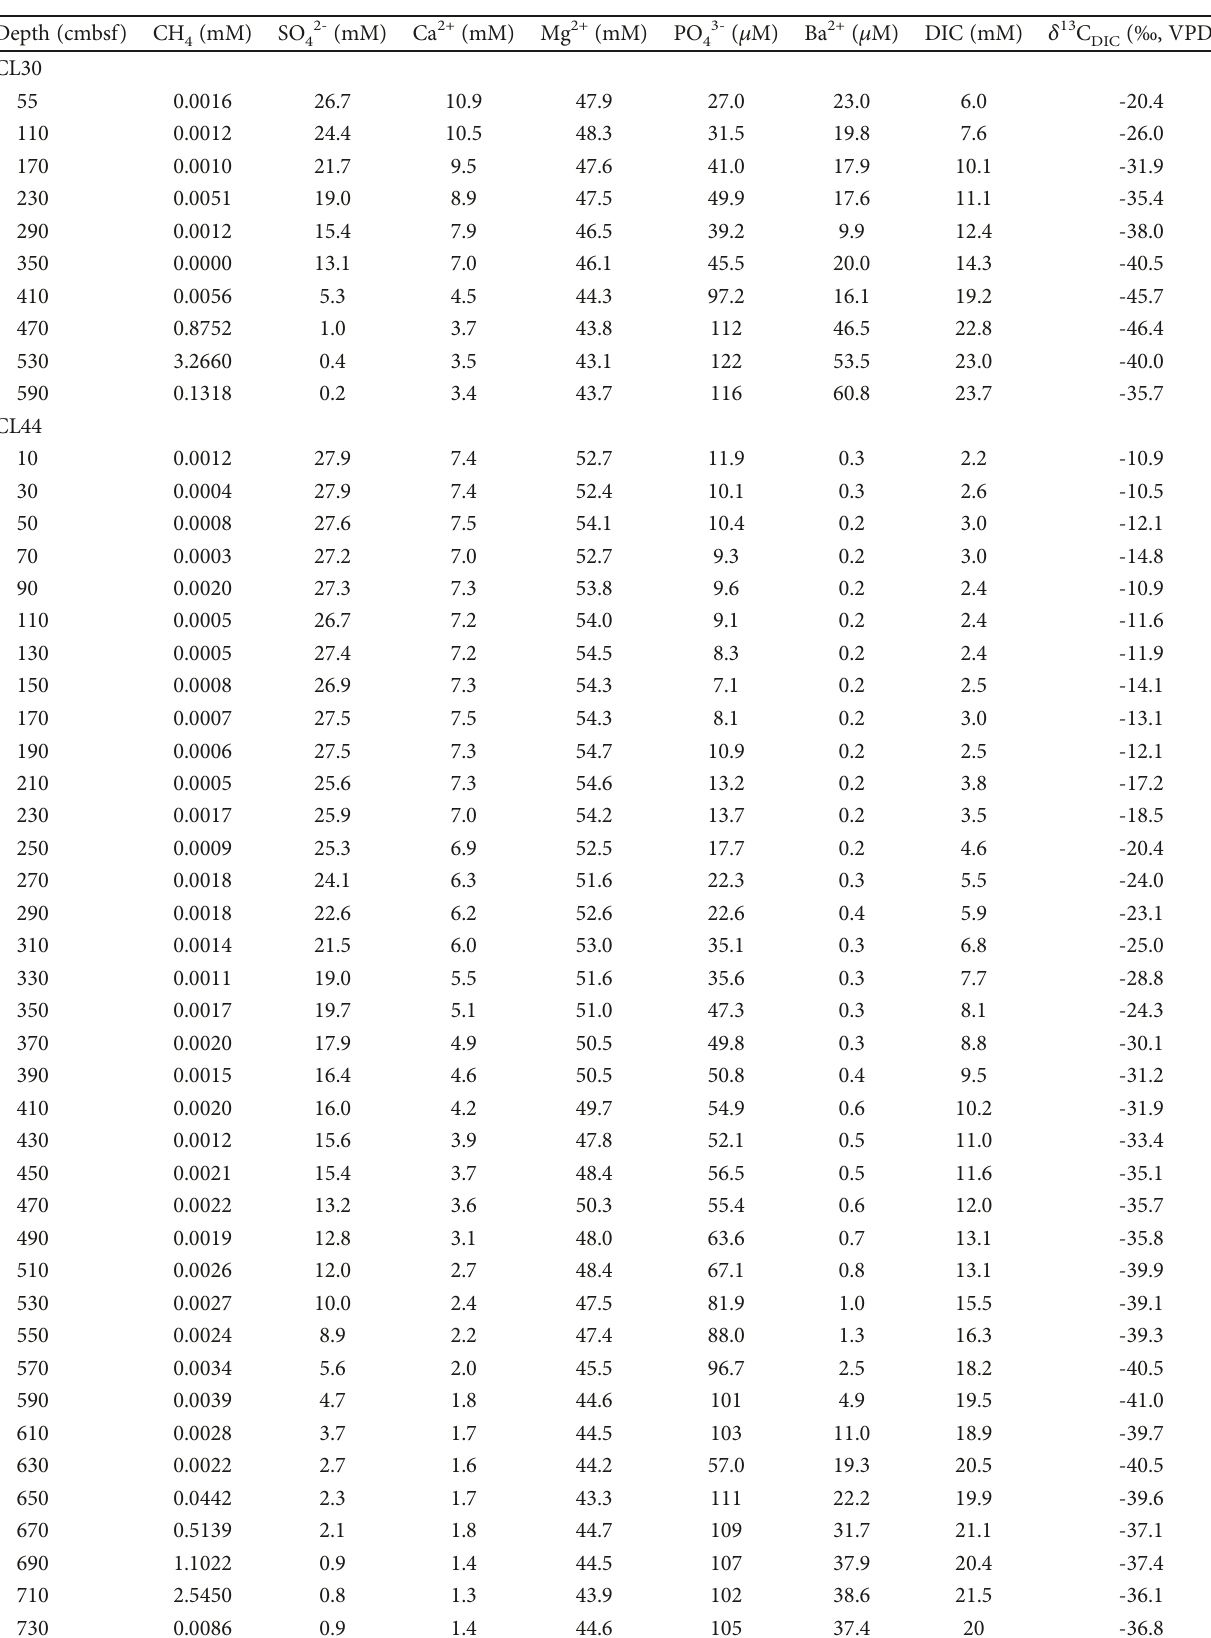
Table 3: Concentrations and isotope ratios of various dissolved components at cores CL30, CL44, and